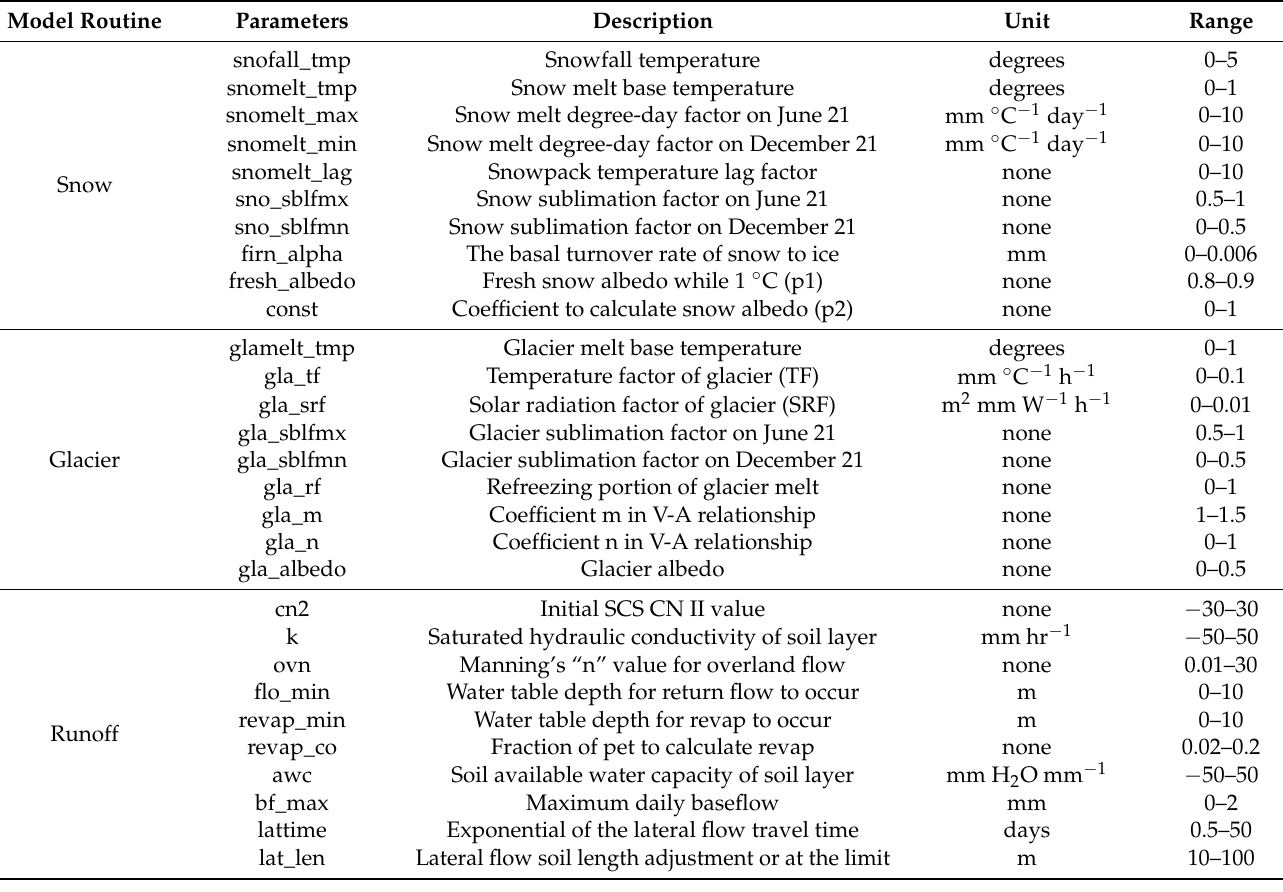
Table 1. Parameters participated in Sensitivity Analysis.